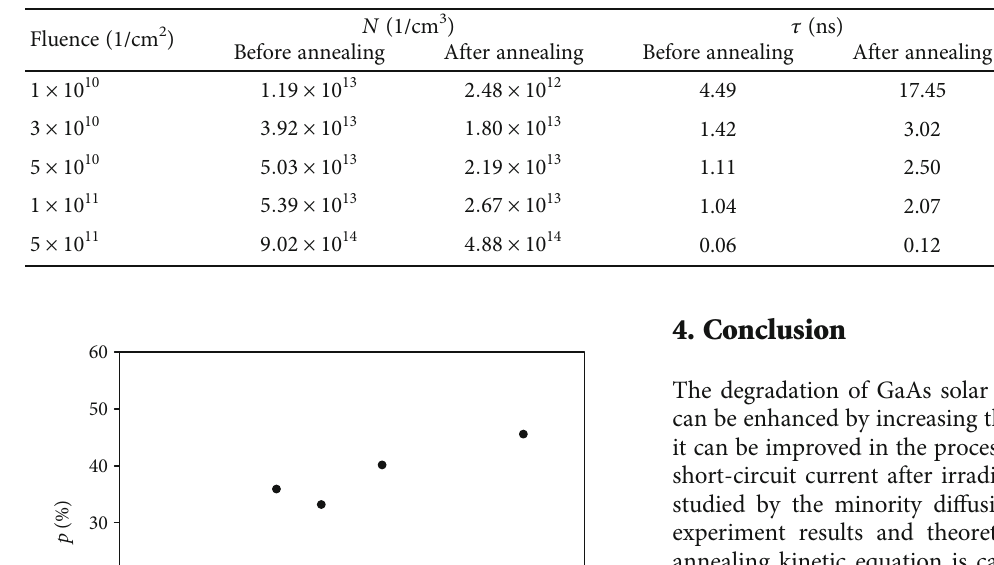
Table 4: The defect concentration and minority carrier lifetime before and after annealing and the annealing rate and the proportion of irrecoverable defects.